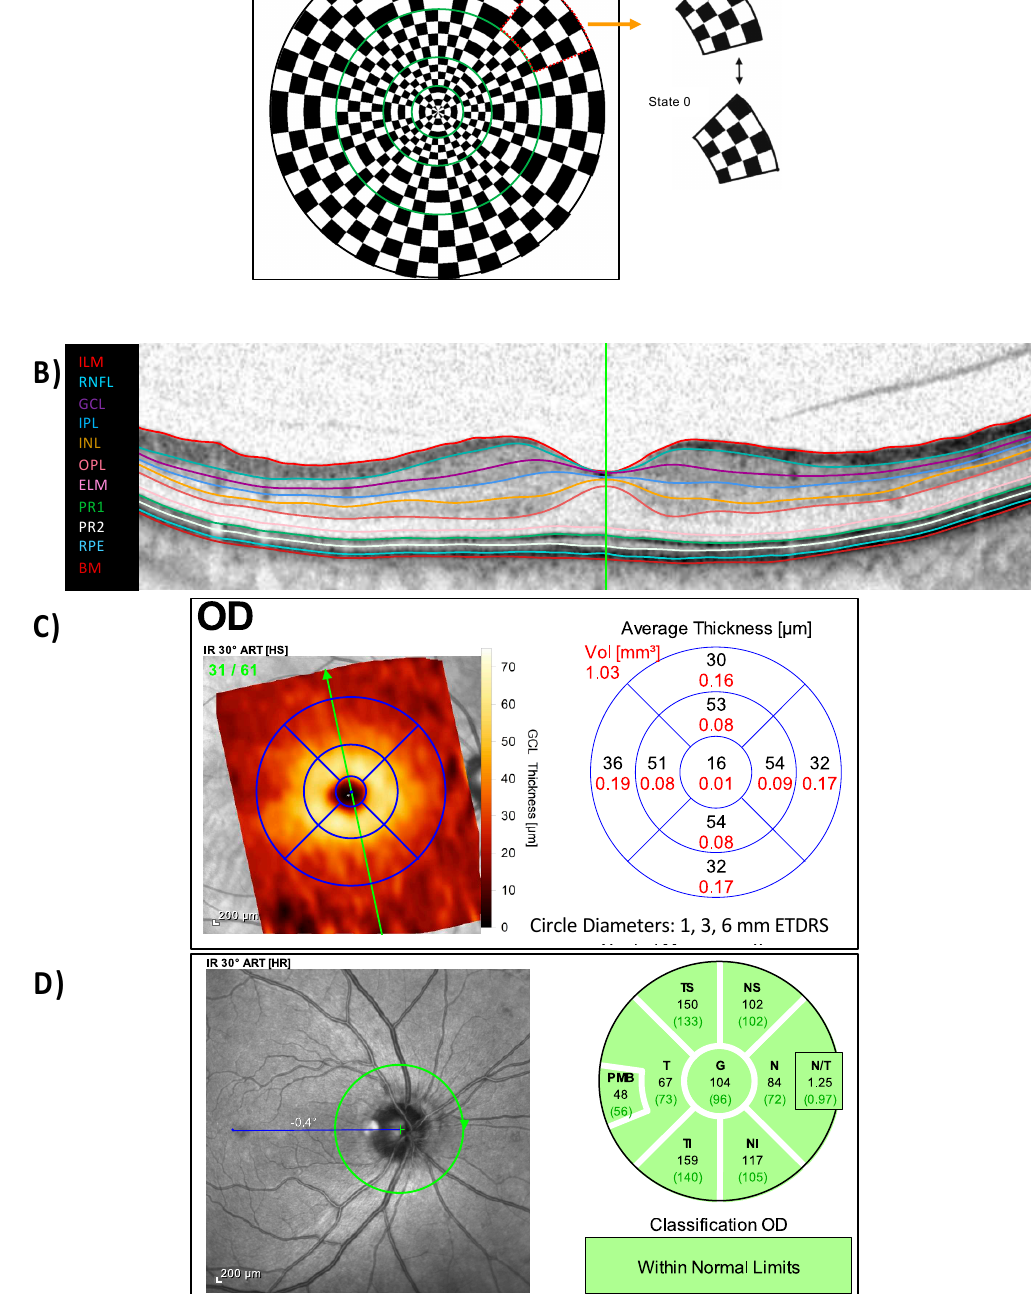
Figure 4. Electroretinography (ERG) and optical coherence tomography (OCT) measurements. ( A ) mfPERG stimulus with 36 checkerboard elements, where each element (dotted red) reverses the pattern between 1 and 0 states. The stimulus (xx° diameter) spanned 4 eccentricity ranges outlined by green line. ( B ) Macular vertical scan with segmentation line, ( C ) Early Treatment for Diabetic Retinopathy Study’s (ETDRS) circle, i.e., 1 mm (foveal), 3 mm (parafoveal), and 6 mm (perifoveal) circles, analysis of the ganglion cell layer (GCL), and ( D ) peripapillary area scan with different sector thickness. ILM = internal limiting membrane; RNFL = retinal nerve fiber layer thickness; GCL = ganglion cell layer; IPL = inner plexiform layer; INL = inner nuclear layer; OPL = outer plexiform layer; ELM = external limiting membrane; PR1 = photoreceptor inner segments; PR2 = photoreceptors outer segments; RPE = retinal pigment epithelium; BM = Bruch’s membrane. Peripapillary retinal nerve fiber layer thickness: G = global average thickness; T = temporal; PMB = papillomacular bundle; N/T: nasal/temporal ratio; S: superior; I: Inferior.